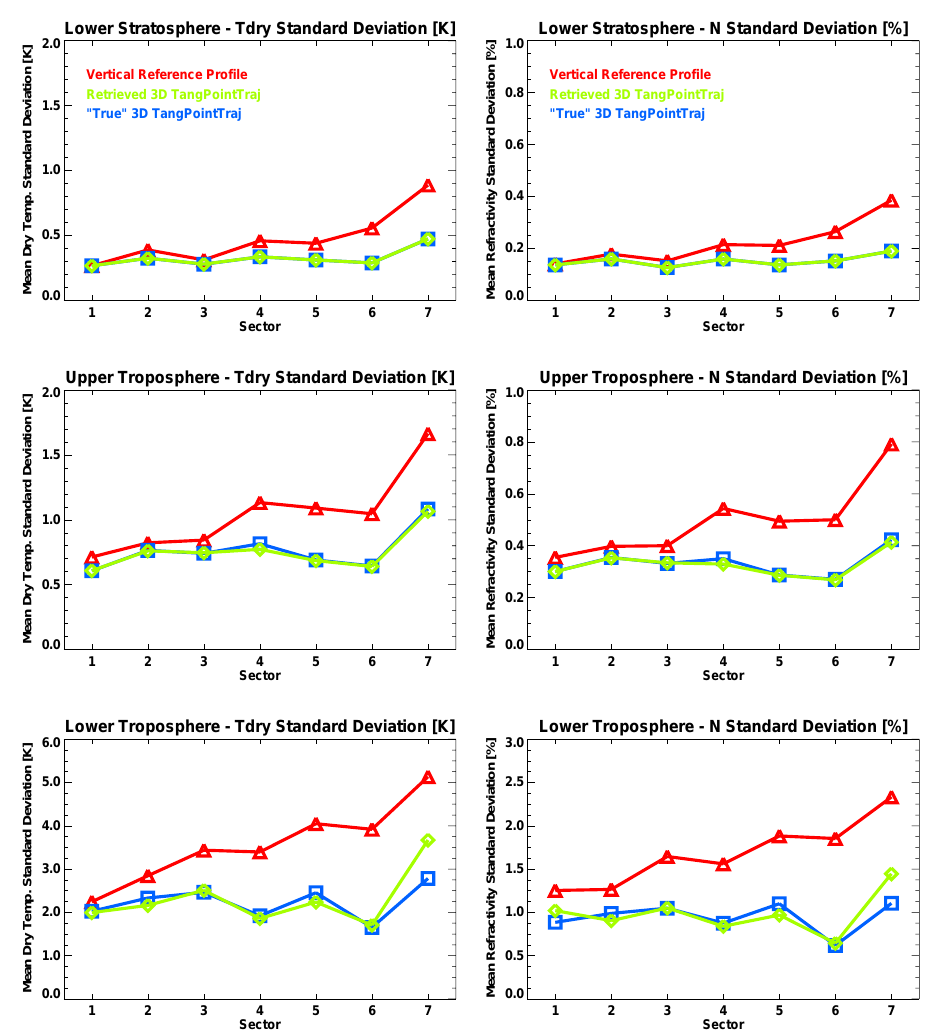
Figure 6. Mean standard deviations of dry temperature (left) and refractivity (right) in the lower stratosphere between 20 km and 25 km altitude (top), in the upper troposphere between 5 km and 10 km (middle), and in the lower troposphere below 5 km (bottom; note the different y-axis range).